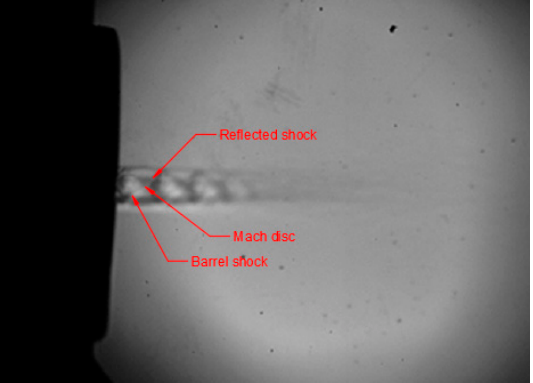
Figure 15. Shadowgraph of a supersonic nozzle taken with a Imperx B2020M camera, and an exposure time of 0.5 ms.